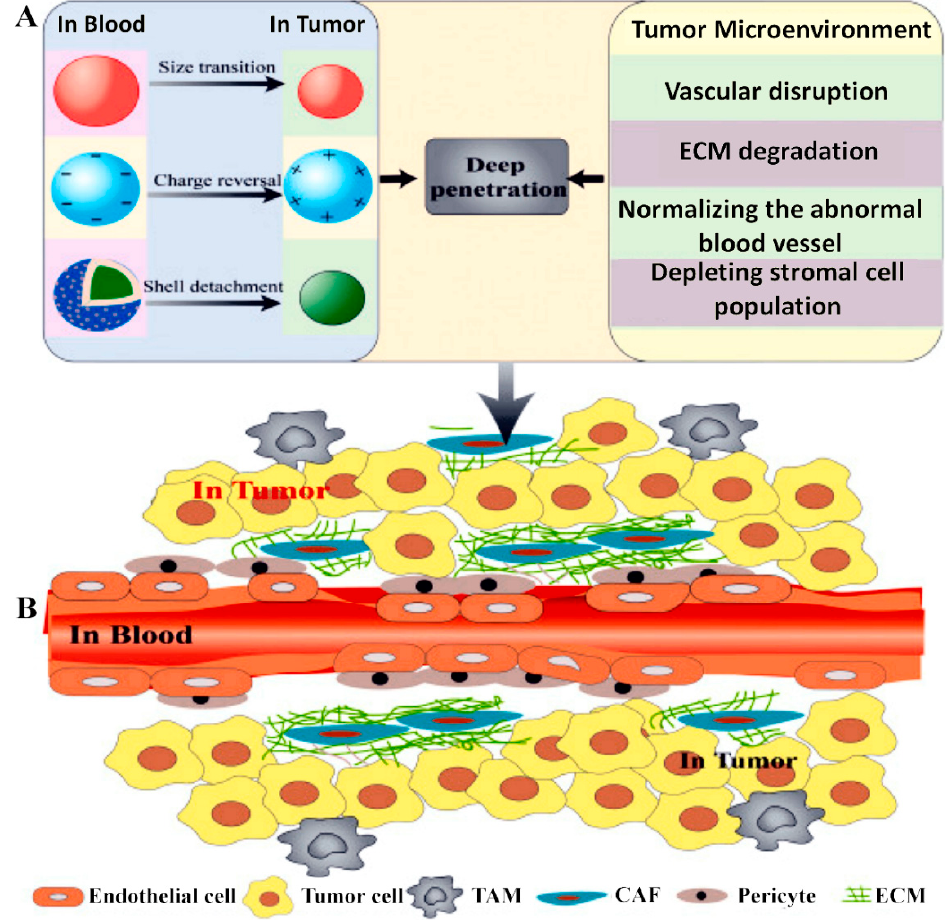
Figure 3. ( A ) Representation summarizing current strategies to improve the tumor penetration of NCs in response of tumor microenvironment. ( B ) Scheme of tumor vasculature and microenviron- ment. Reprinted with permission from Ref. [272], Copyright 2021, Elsevier.